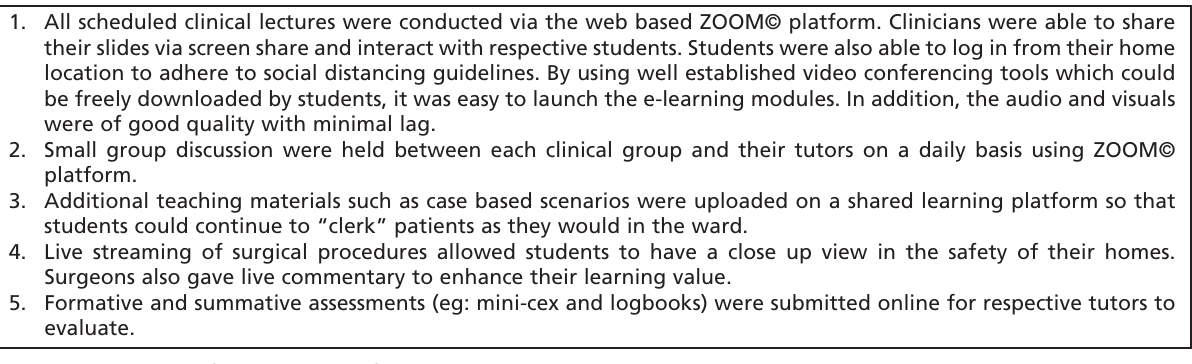
Online models of clinical teaching for medical undergraduates 26 Fig. 4: